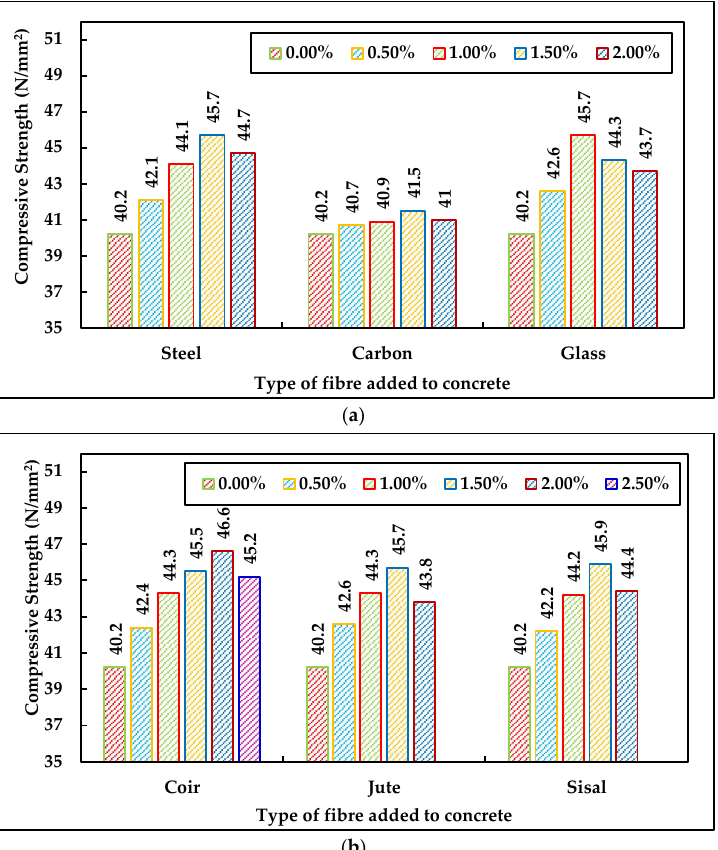
Figure 6. Graphical illustration of compressive strength of FRC. ( a ) Artificial fibre reinforced concrete, ( b ) Natural fibre reinforced concrete.